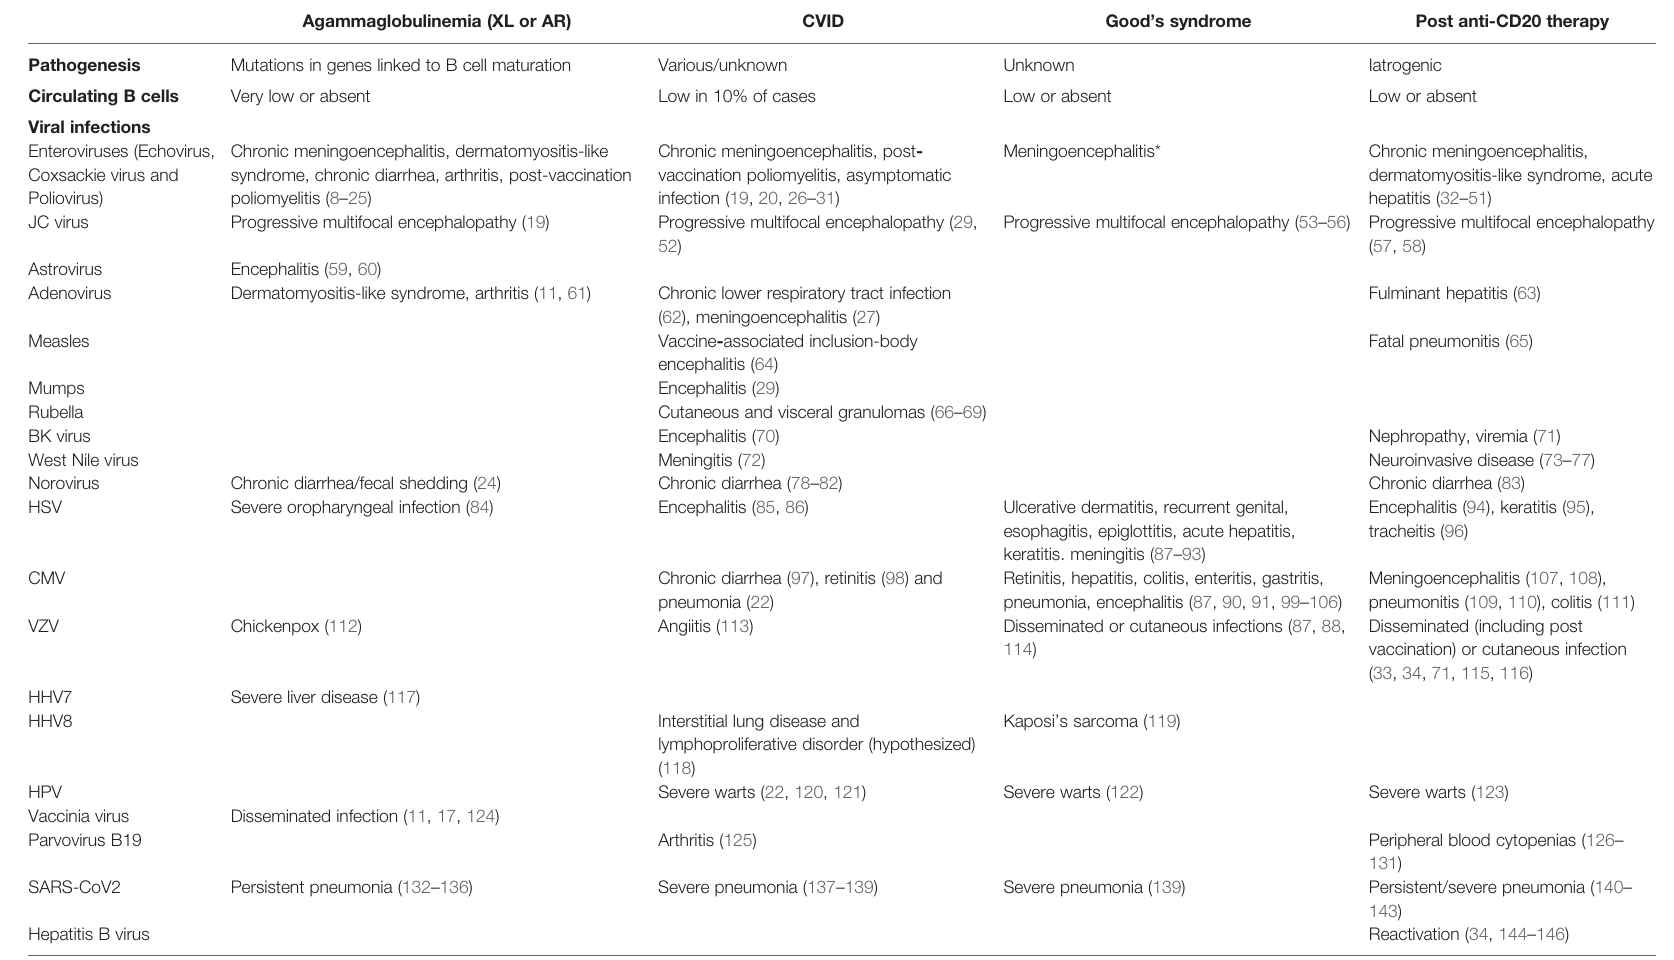
TABLE 1 | Viral infections in patients with agammaglobulinemia, Good ’ s syndrome, CVID and post-B cell-depleting